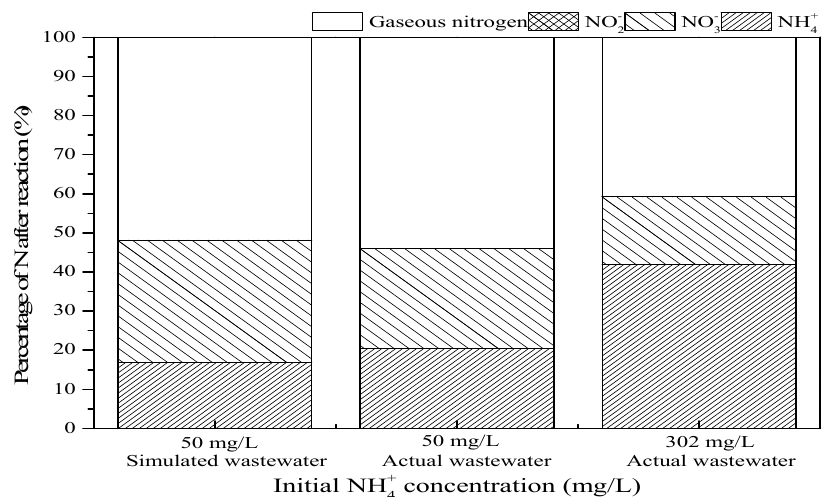
Figure 11. Comparison of oxidation of simulated wastewater and actual NH 4 + -containing wastewater in SrO-Al 2 O 3 / US / O 3 system. Reaction conditions: initial pH 9.5, ozone flow 0.8 g / h, catalytic dosage 2.0 g / L, temperature 25 ◦ C, reaction time 60 min, ultrasonic frequency 25 kHz, ultrasonic power 270 W, duty cycle 1:3.